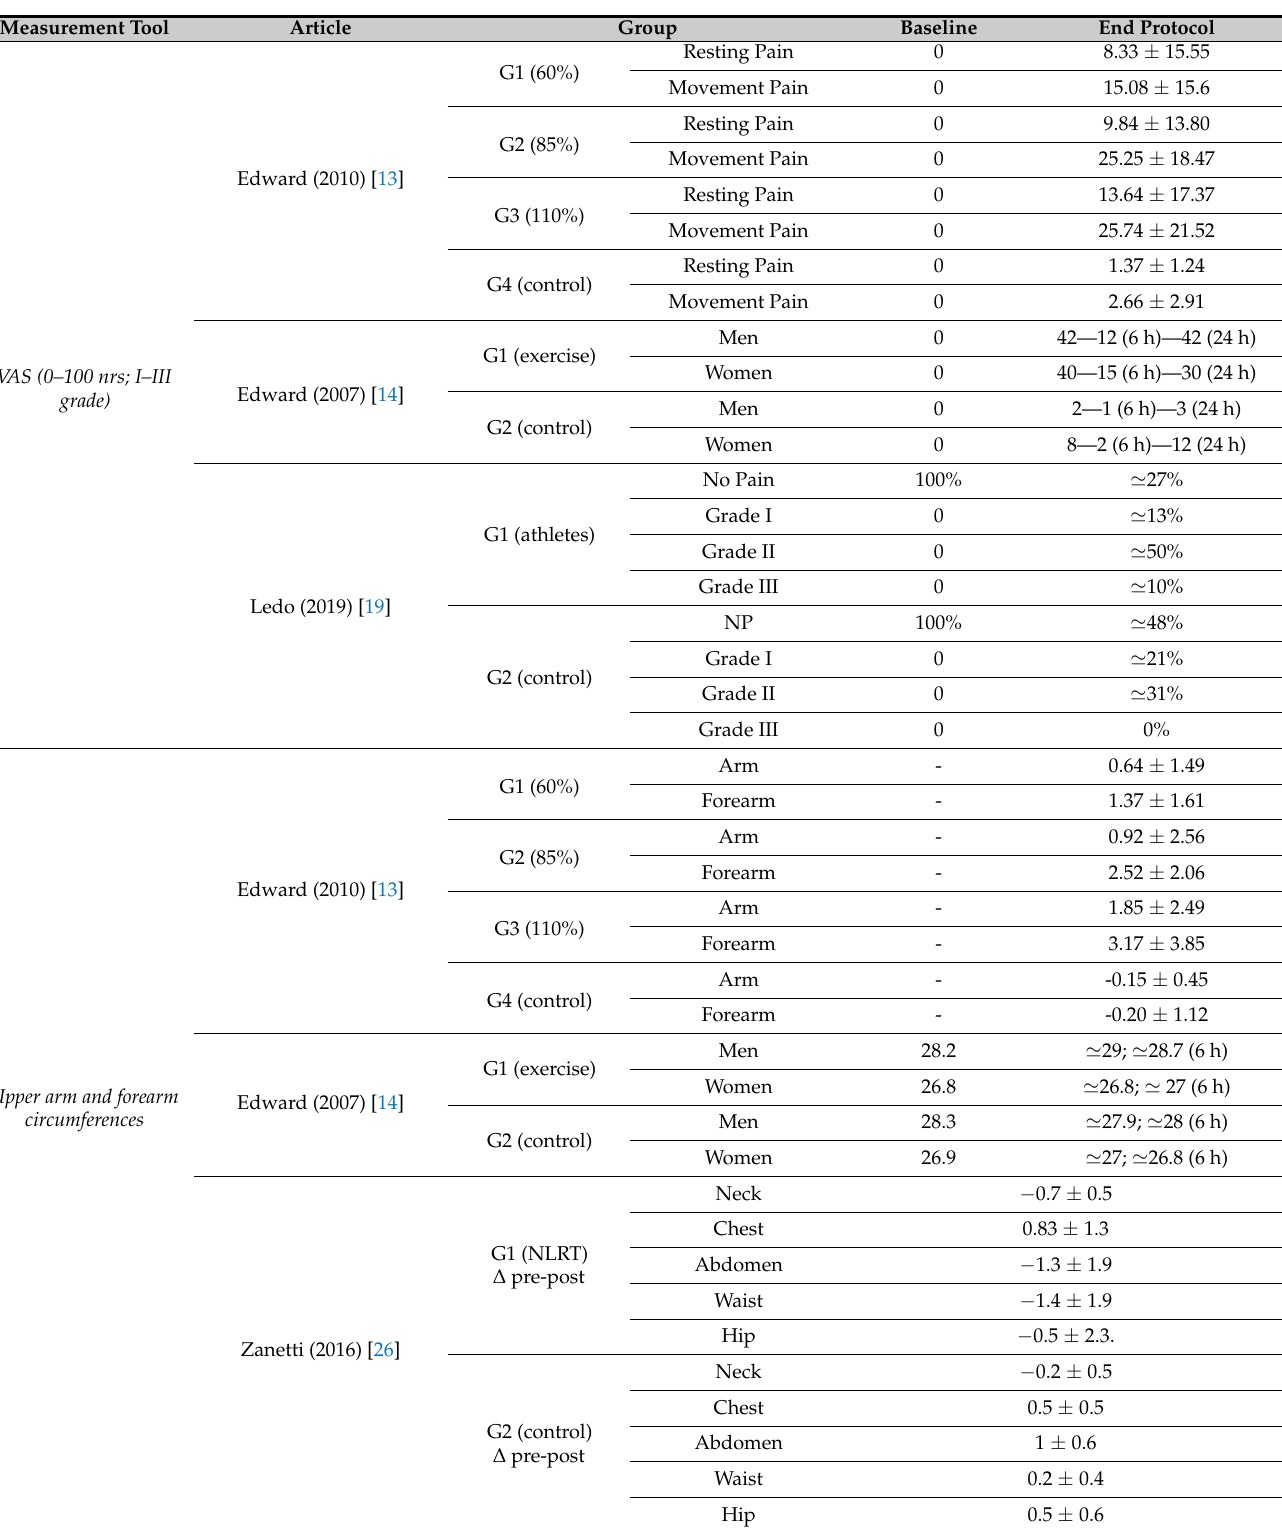
Table 4. Results of the pain and physical performance variables analyzed in the studies included in this systematic